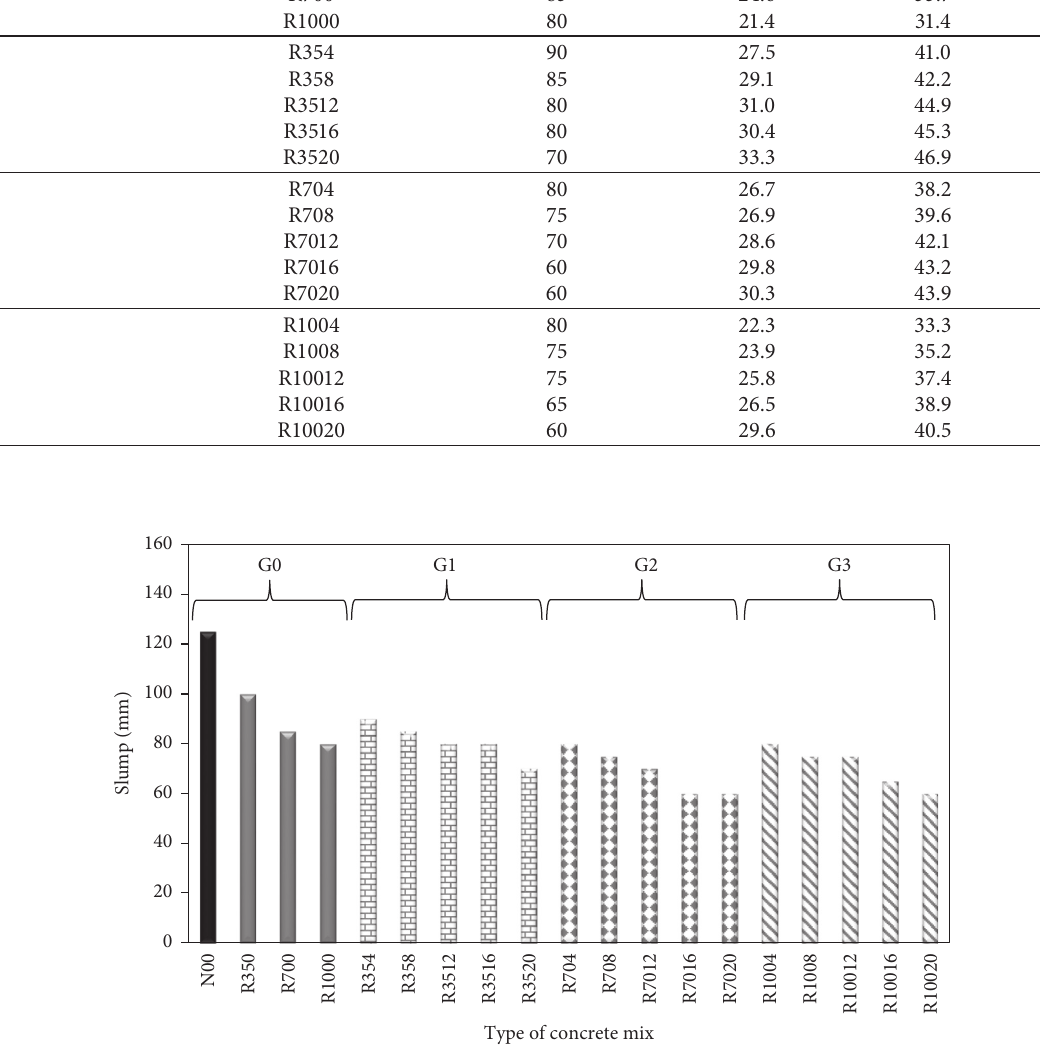
Figure 6: Slump values of all